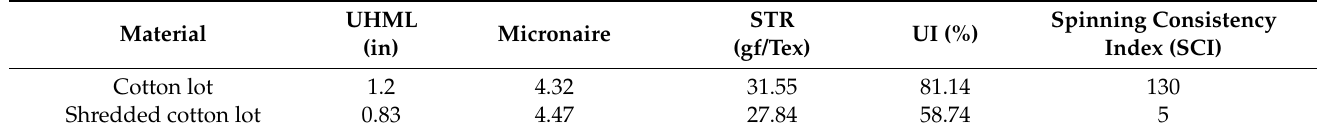
Table 3. Reliability index.